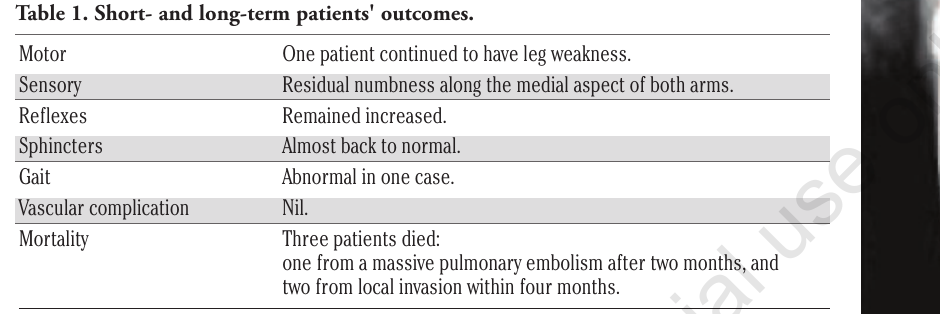
Figure 3. (A) A left verte- bral artery angiogram demonstrates a large artery feeder arising from the left vertebral artery (V2 segment) with a tumor blush (arrow). (B) Post-endovascular embol - ization angiogram illus- trates obliteration of the tumor feeder and decreased tumor blush (arrow).